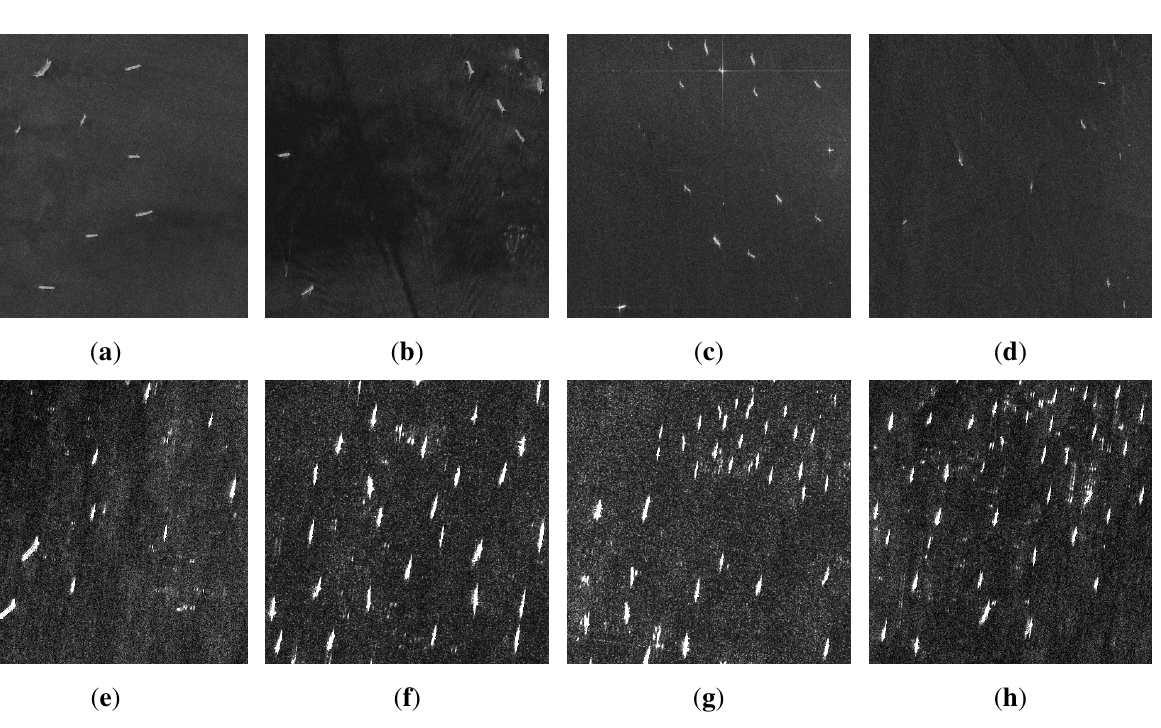
Figure 2. SAR amplitude images of the test areas. ( a , b ) The TerraSAR-X data, acquired on 12 May 2008, over Gibraltar, having a 3-m spatial resolution and HH polarization. ( c , d ) RADARSAT-2 data, acquired on 5 March 2011, over Istanbul, Turkey, also having a 3-m spatial resolution and HH polarization. ( e – h ) TerraSAR-X data, acquired on 13 December 2009, over Istanbul,